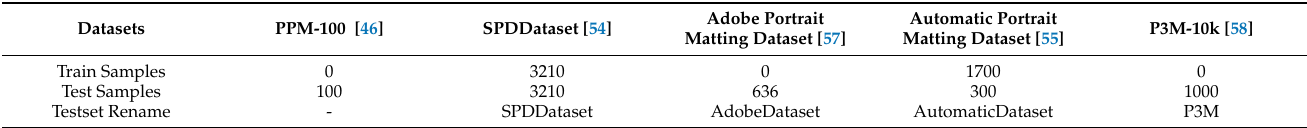
Table 2. Dataset description for portrait